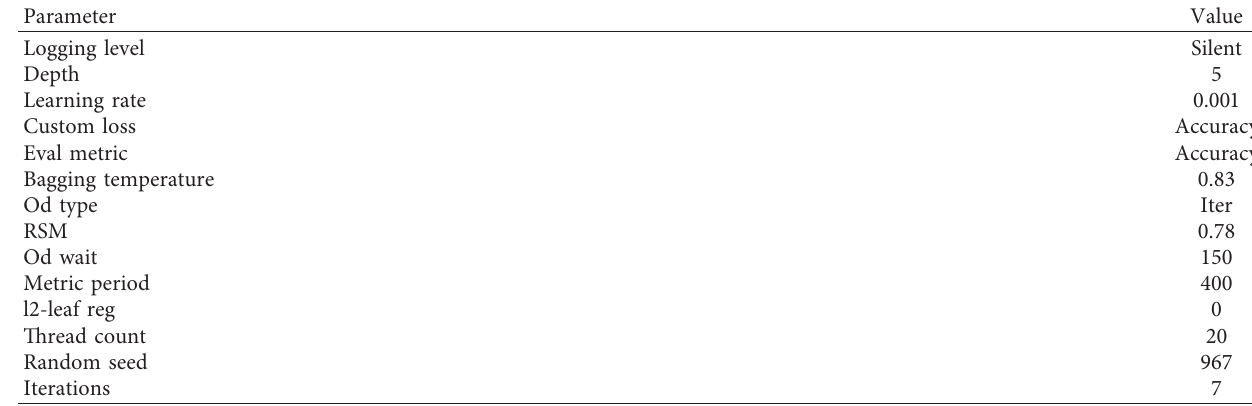
Table 4: The parameter settings of the CatBoost.